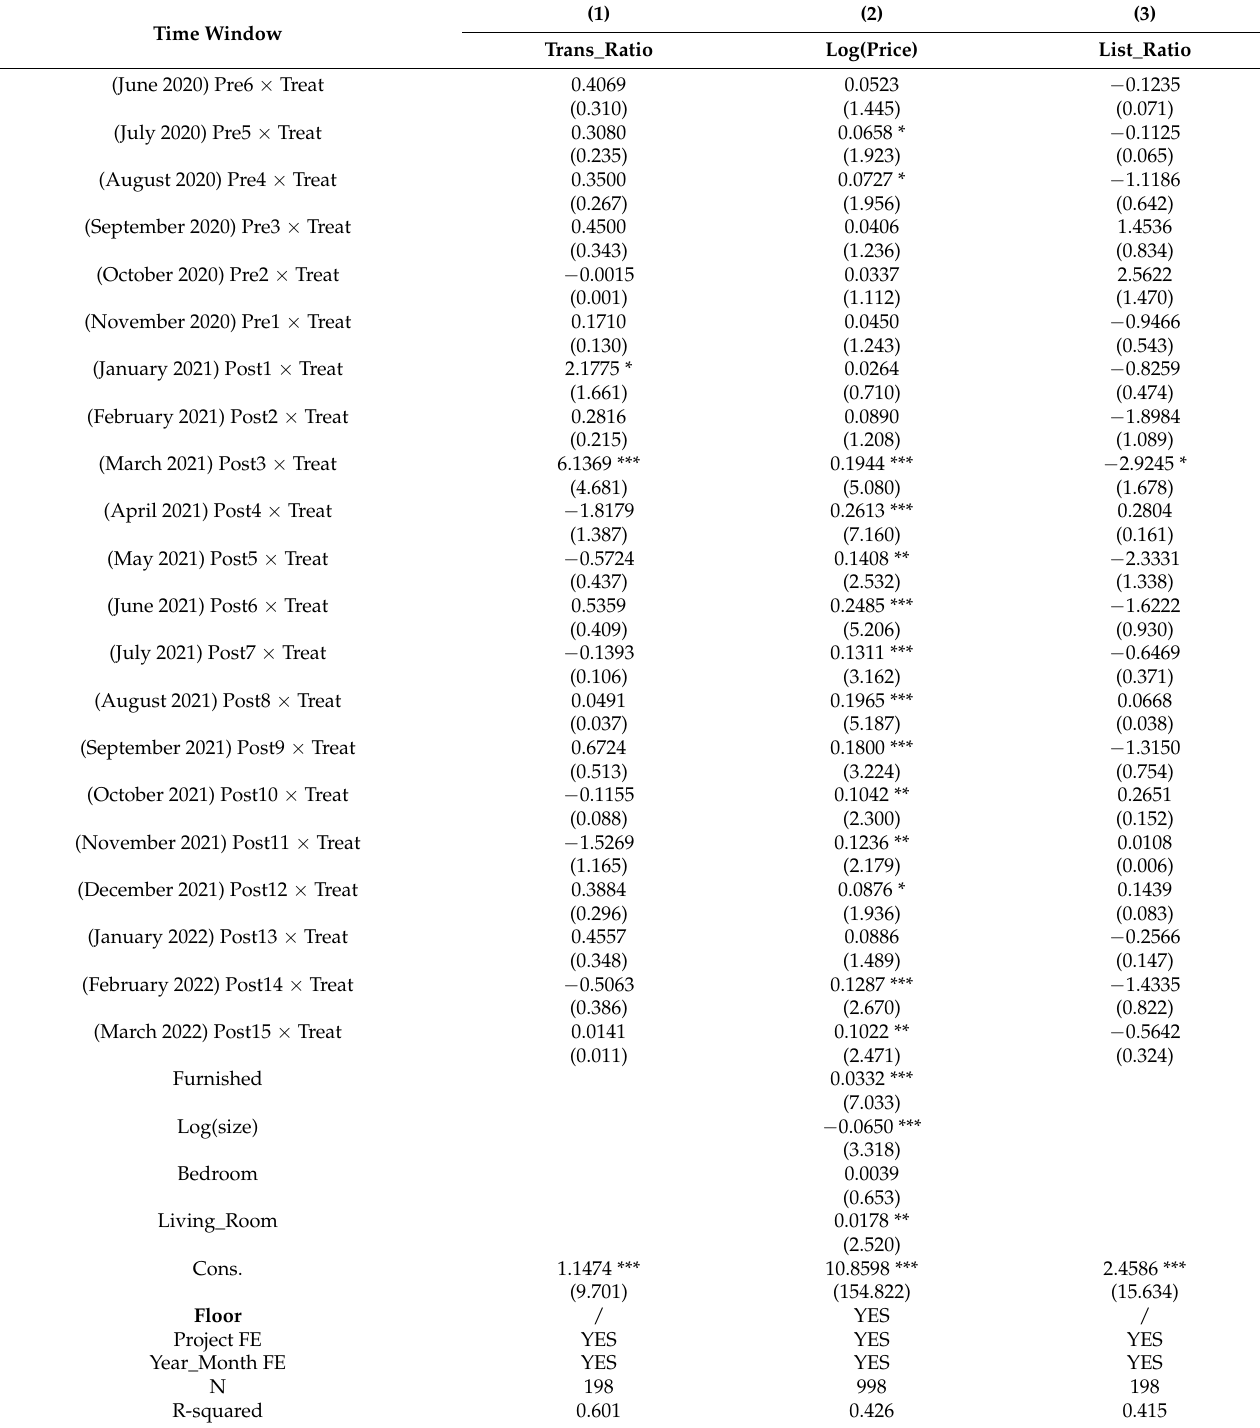
Table 3. Impacts on transaction and listing